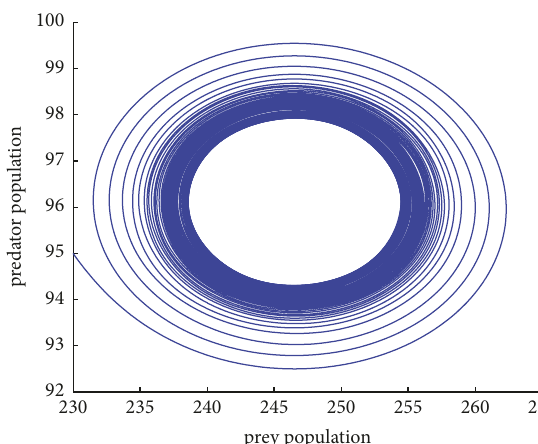
Figure 15: The phase portrait of delayed model (3) with the time delays 𝜏 1 = 0.25 and 𝜏 2 = 0 . The parameters are taken as 𝑥(0) = 230 , 𝑦(0) = 95 , 𝐴 = 0.01 , 𝑟 = 2.65 , 𝐾 = 900 , 𝑎 = 0.02 , 𝑐 = 0.215 , and 𝑚 = 1.06 ; 𝐸 = (𝑥 ,𝑦 ) becomes unstable; a limit cycle is formed. ∗ ∗ ∗